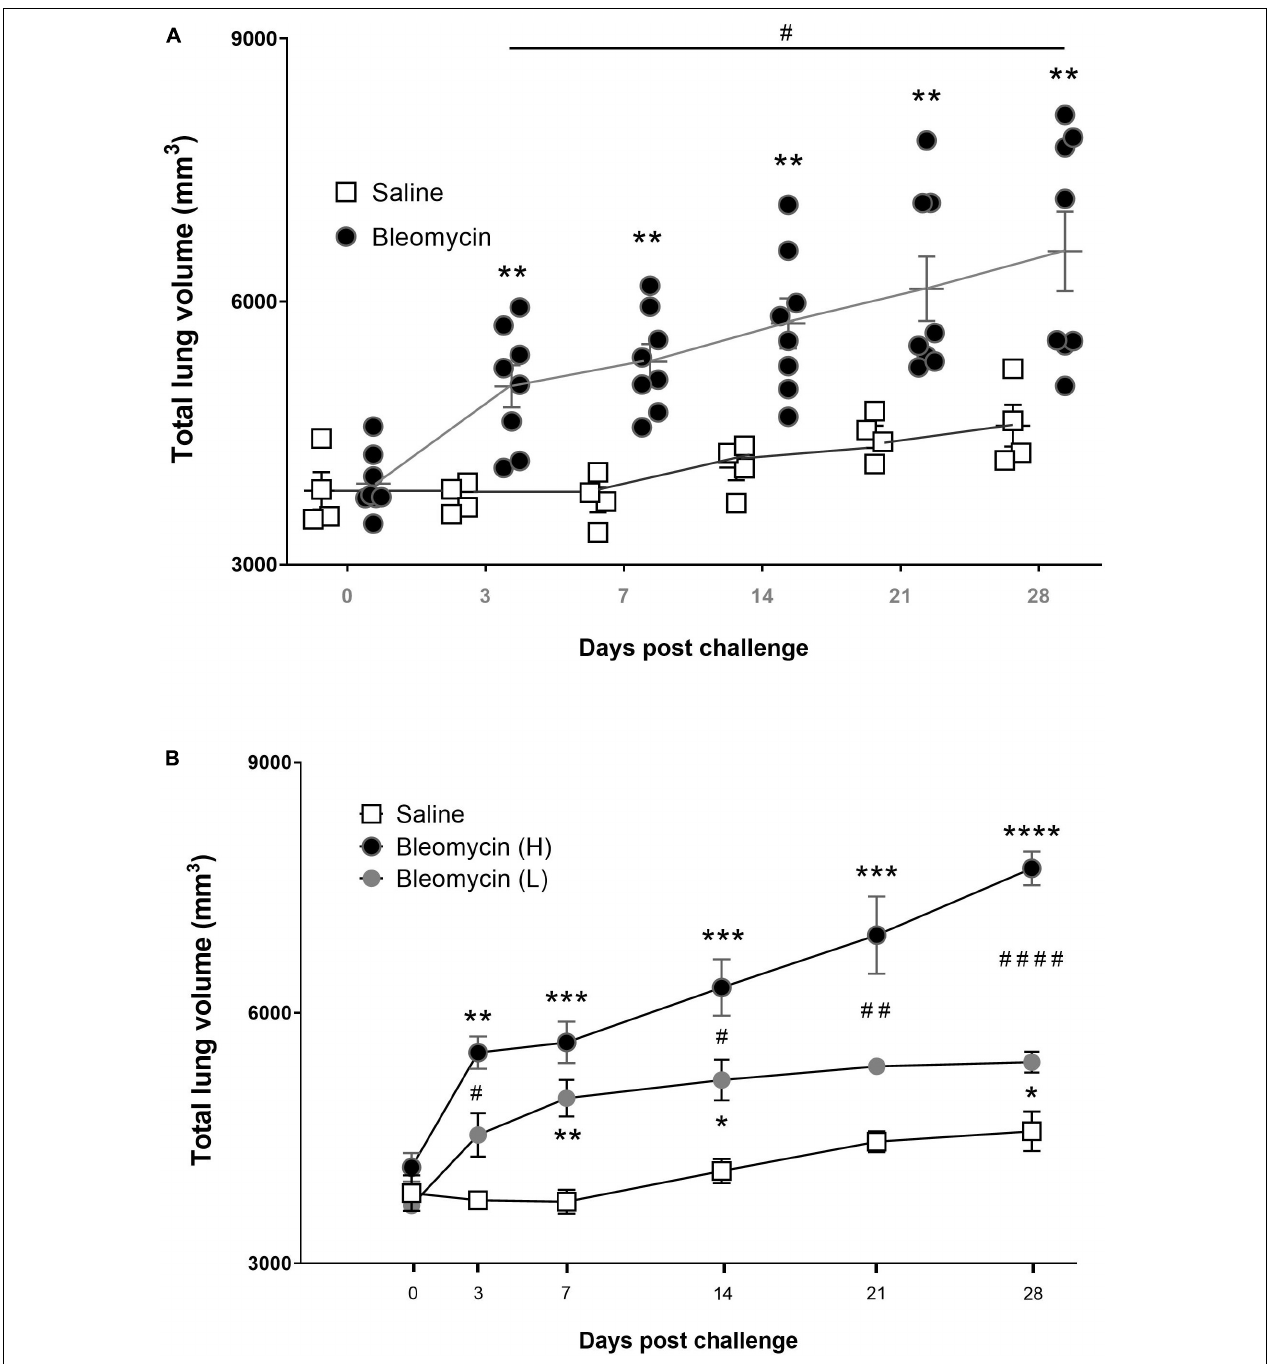
FIGURE 4 | Lung volume changes post bleomycin challenge. (A) Total lung volume presented as mm 3 in saline vs. bleomycin groups for all measured time points. The total lung volume data are generated from the MR-images with ROI, showing here that bleomycin challenge induced an increase in total lung volume compared to saline control. Later time points (day 21 – 28) revealed segmented populations of rats that responded differently, where the total lung volume change was further increased or recovered back toward baseline, being high- and low-responders, respectively. (B) Total lung volume change presented according to the different groups; saline, low-responders (L) and high-responders (H). Significance is indicated by * when p < 0.05; p < 0.01 by **; p < 0.001 by *** and p < 0.0001 by ****, when comparing bleomycin towards the saline control from the same time point. The comparison of various time points between bleomycin-challenged groups is expressed as # when p < 0.05; ## when p < 0.01 and #### when p < 0.0001.